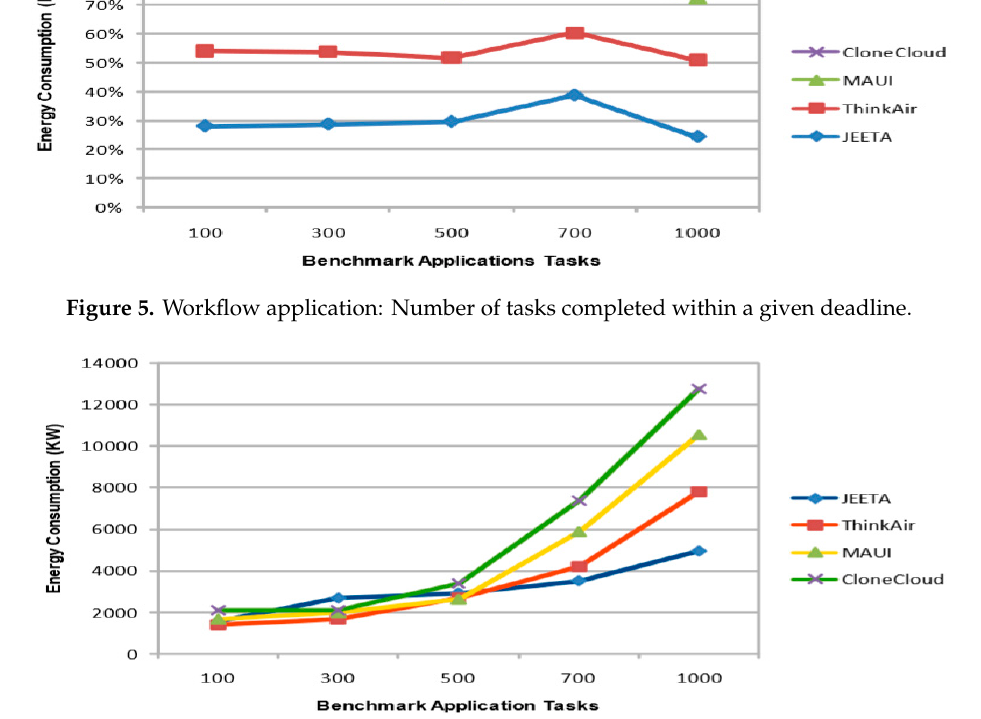
Figure 6. Workflow application number of tasks completed within a given deadline.